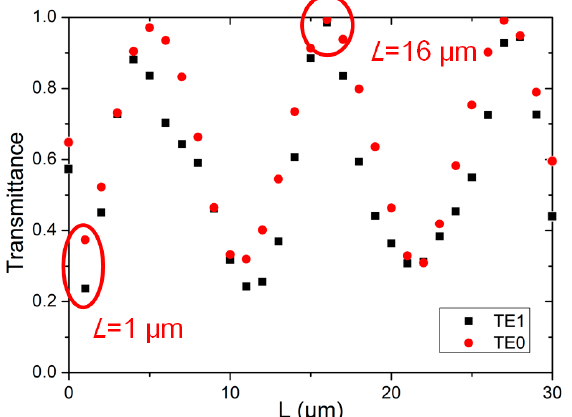
Figure 3. Simulation results of length dependency of a straight multimode bus waveguide between two sharp Euler bends.